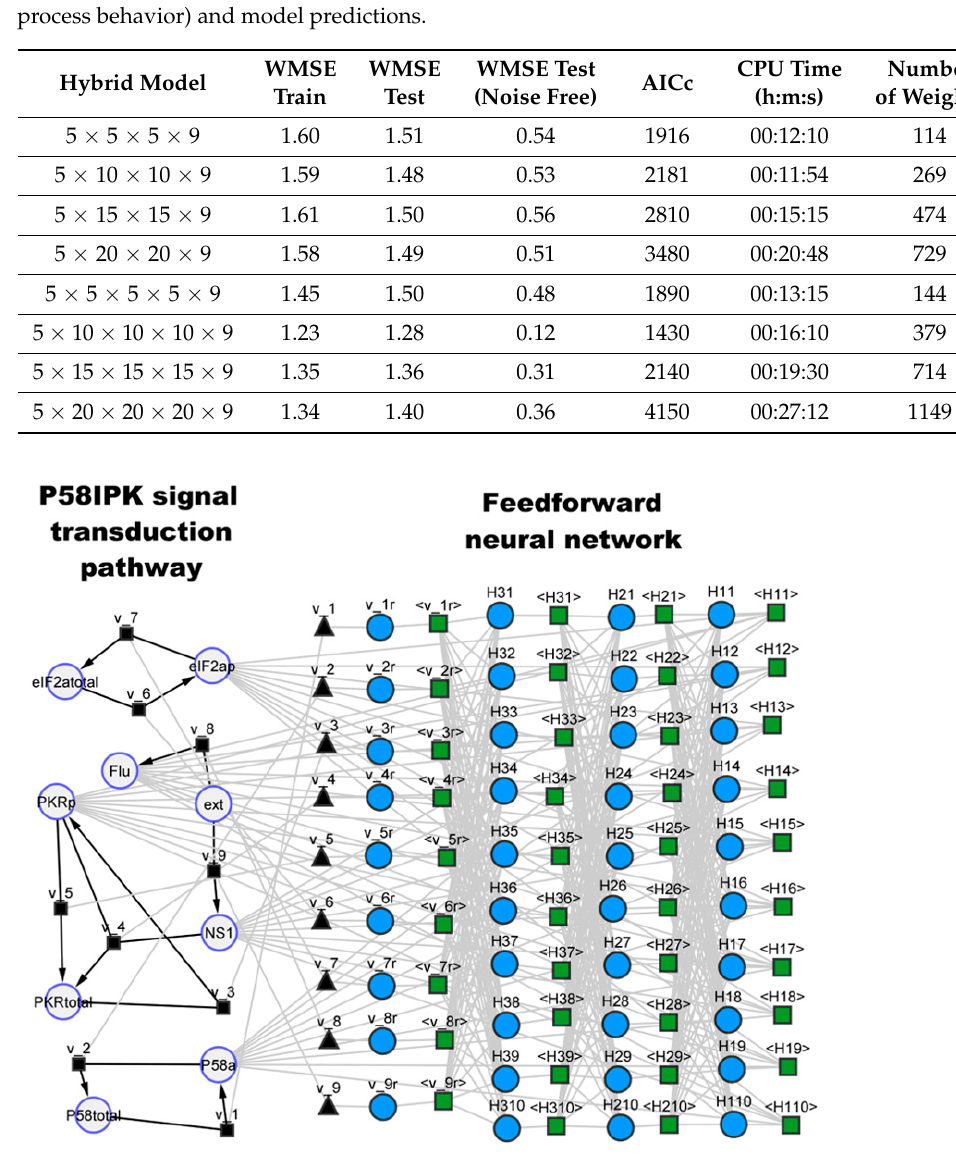
Figure 4. Hybrid model structure [5 × 10 × 10 × 10 × 9] for the P58IPK signal transduction pathway (6th row of Table 3) visualized using the cy3sbml tool [43]. Left side : Signal transduction network with physical meaning. Large circles represent biochemical species (proteins). Black squares and black edges represent biochemical reactions. Black triangles represent kinetic laws. Right side : Artificial feedforward neural network with size [5 × 10 × 10 × 10 × 9]. Small blue circles represent neural network nodes. Green squares and gray edges represent signal propagation between neural network nodes. The first layer receives input signals of biochemical species concentrations (Large circles). The last layer delivers kinetic parameter values to the black triangles, which mediate the communication between both sides of the network.